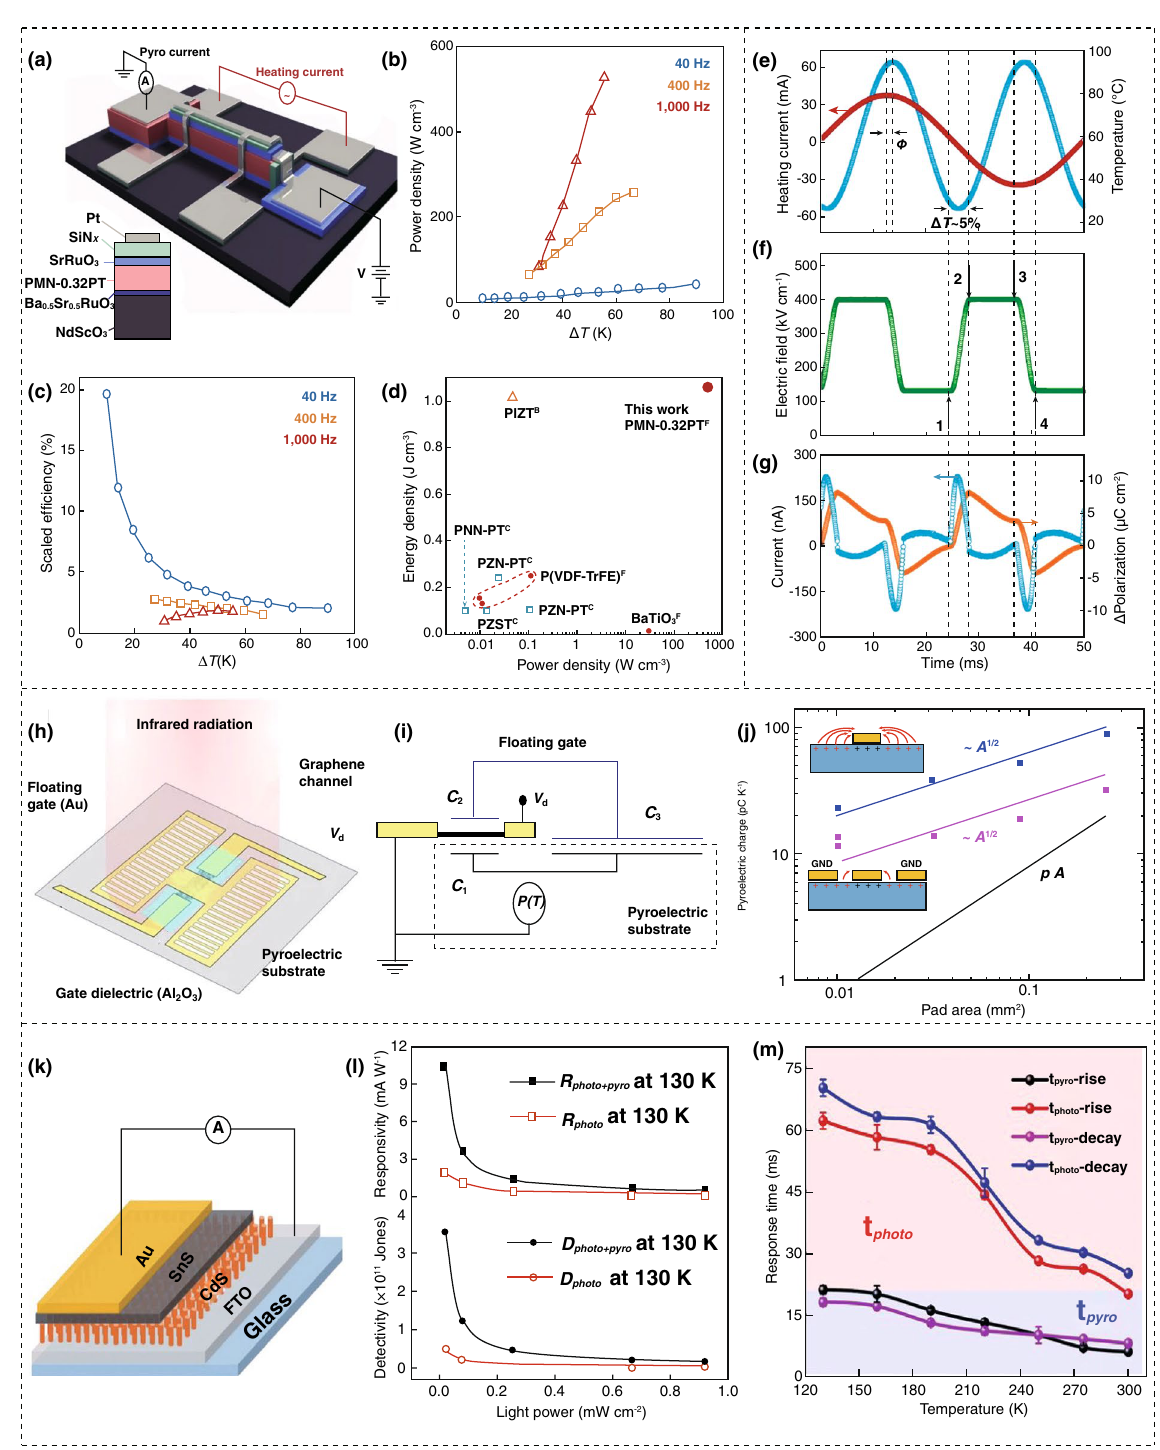
Fig. 8 Device fabrication and output performances of pyroelectric nanogenerators. a Illustration of device structure. b Power density. c Scaled effi- ciency of the device. d Comparison of this work with other reports. e Application of Ericsson cycle with varying temperature (blue line) and electric field (red line). f Implementing a periodic current across the relaxor. g Output current and resulting polarization in response to varying temperatures. h Schematic of device with a graphene channel and floating gate. i Device circuit diagram. j Accumulated pyroelectric charge according to pad area. k Schematic structural diagram. l Device responsivity with detectivity. m Responding period of the pyro and photoelectric effect. Figures reprinted with permission from: a , b , c , d , e , f , g Ref. [112], © 2018 Nature; h , i , j Ref. [113], © 2017 Nature; k , l , m Ref. [114], © 2020 Wiley. (Color figure